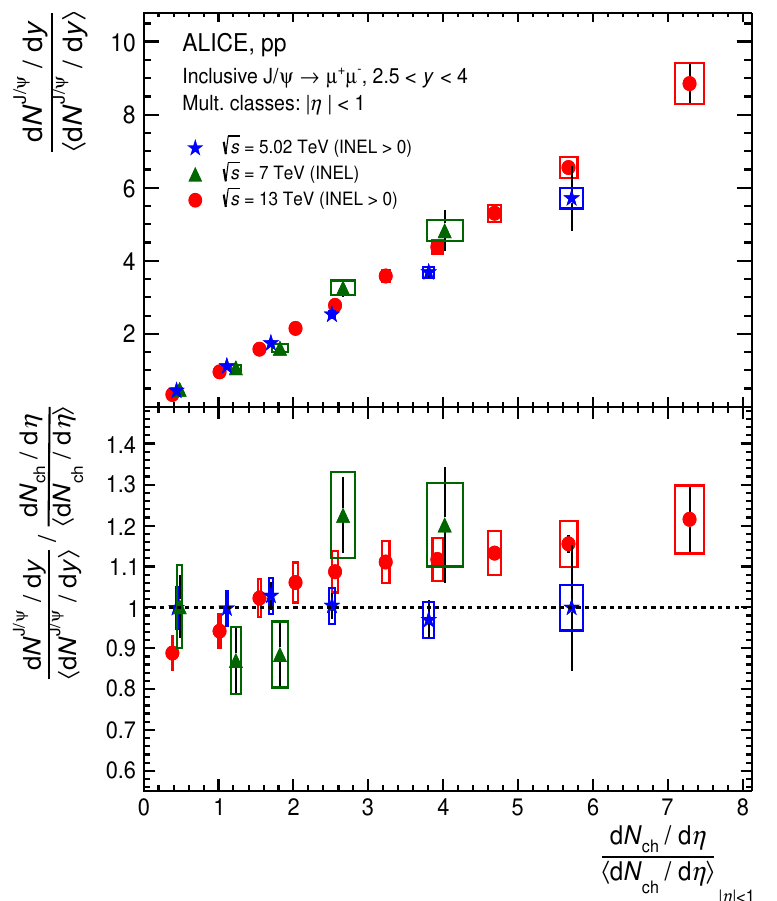
Figure 4 . Relative J/ ψ yield as a function of the relative charged-particle density measured at √ forward rapidity in pp collisions at s = 5.02 (INEL > 0), 7 (INEL) and 13 (INEL > 0) TeV. The bottom panel shows the ratio of relative yield of J /ψ to relative charged-particle density. The vertical bars and the boxes represent the statistical and the systematic uncertainties,